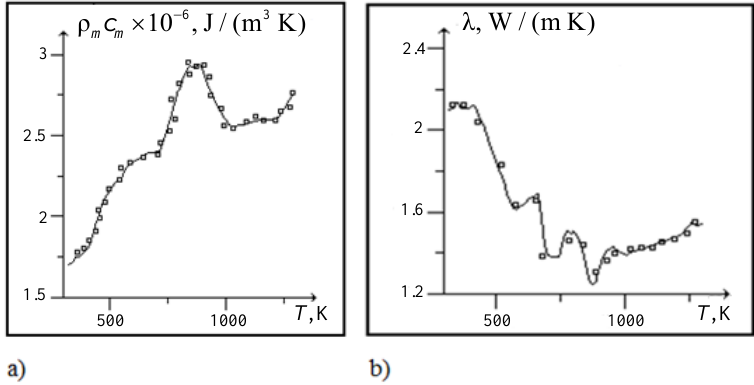
Figure 9. Dependence of volumetric heat capacity coefficient ( a ) and the thermal conductivity coefficient ( b ) on temperature; experimental data.